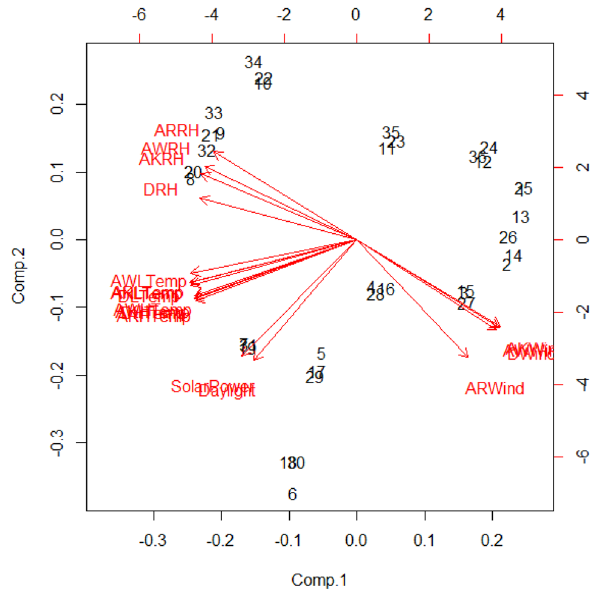
Fig. 7 Biplot graph representation of the Principal Components, which capture 90% of the total variance, and the dependence, correlation, or contribution of each atmospheric variable in deter- mining the latent variable: Principal Component Thermal Comfort Index